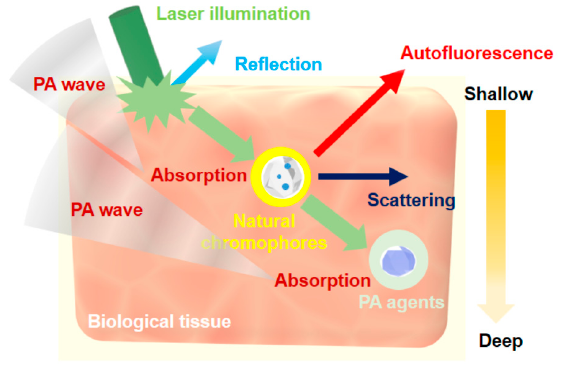
Figure 2. Conceptual depiction of general interactions between light and tissue.